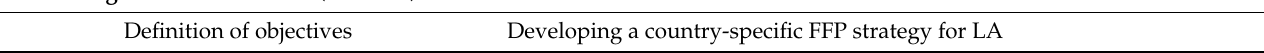
Table 6. Extract of the aspects of the identification of objectives, a strategy, and goals. (Behavioral and) Design Science Research